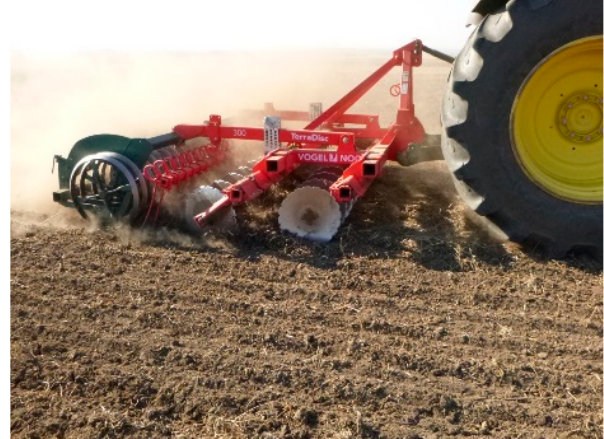
Figure 5. Disking at JTEF (Source: Igor Dekemati).